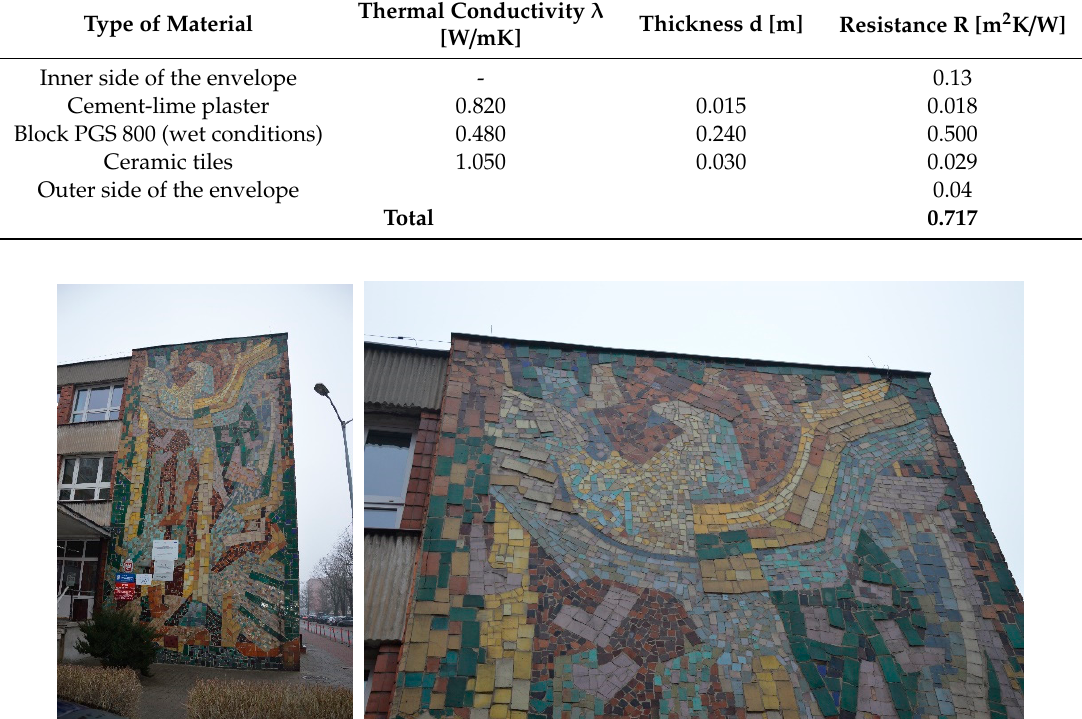
Figure 1. View of a fragment of the facade with glazed ceramic tiles.